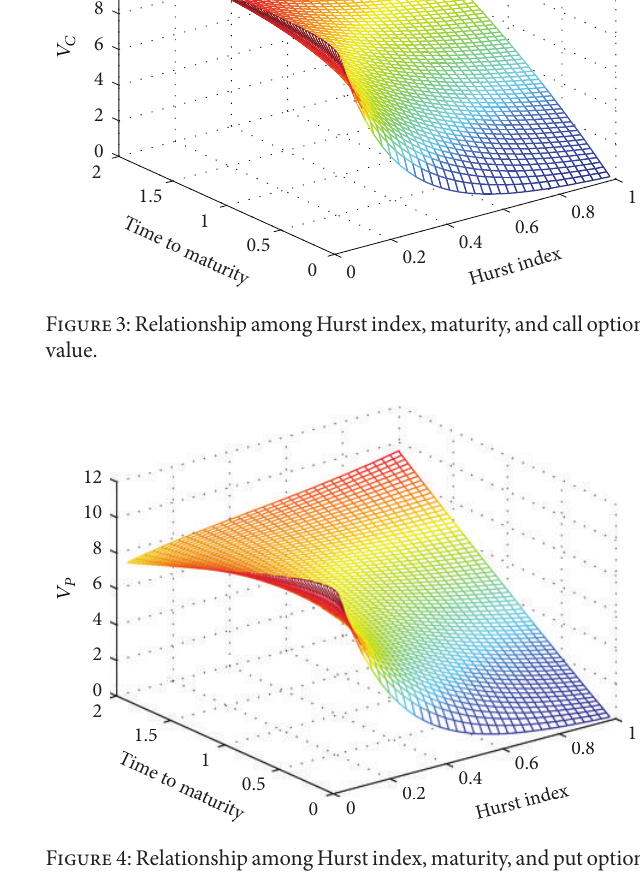
Figure4:RelationshipamongHurstindex,maturity,andputoption